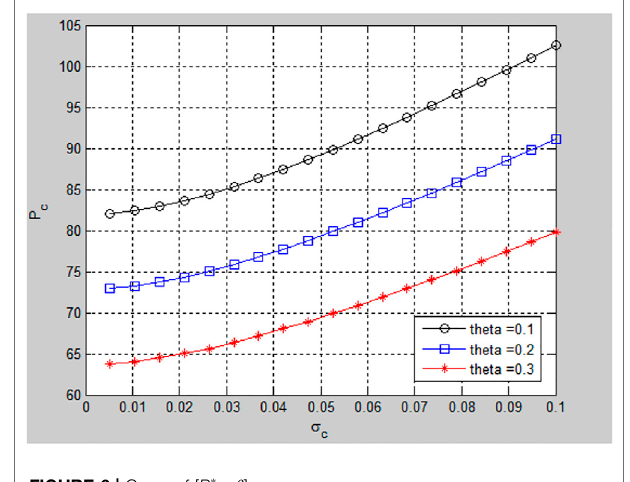
FIGURE 6 | Curve of [ P p c − θ ]